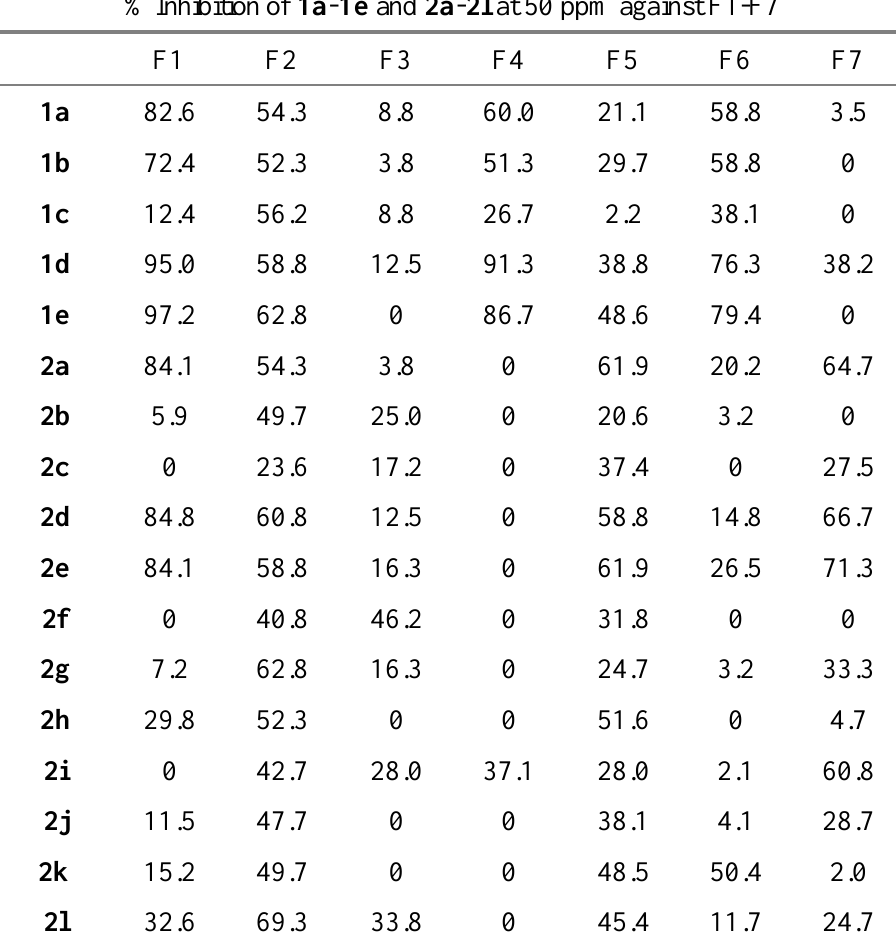
Table 2. Percentage inhibition of compounds 1a-1e and 2a-2l against the fungi